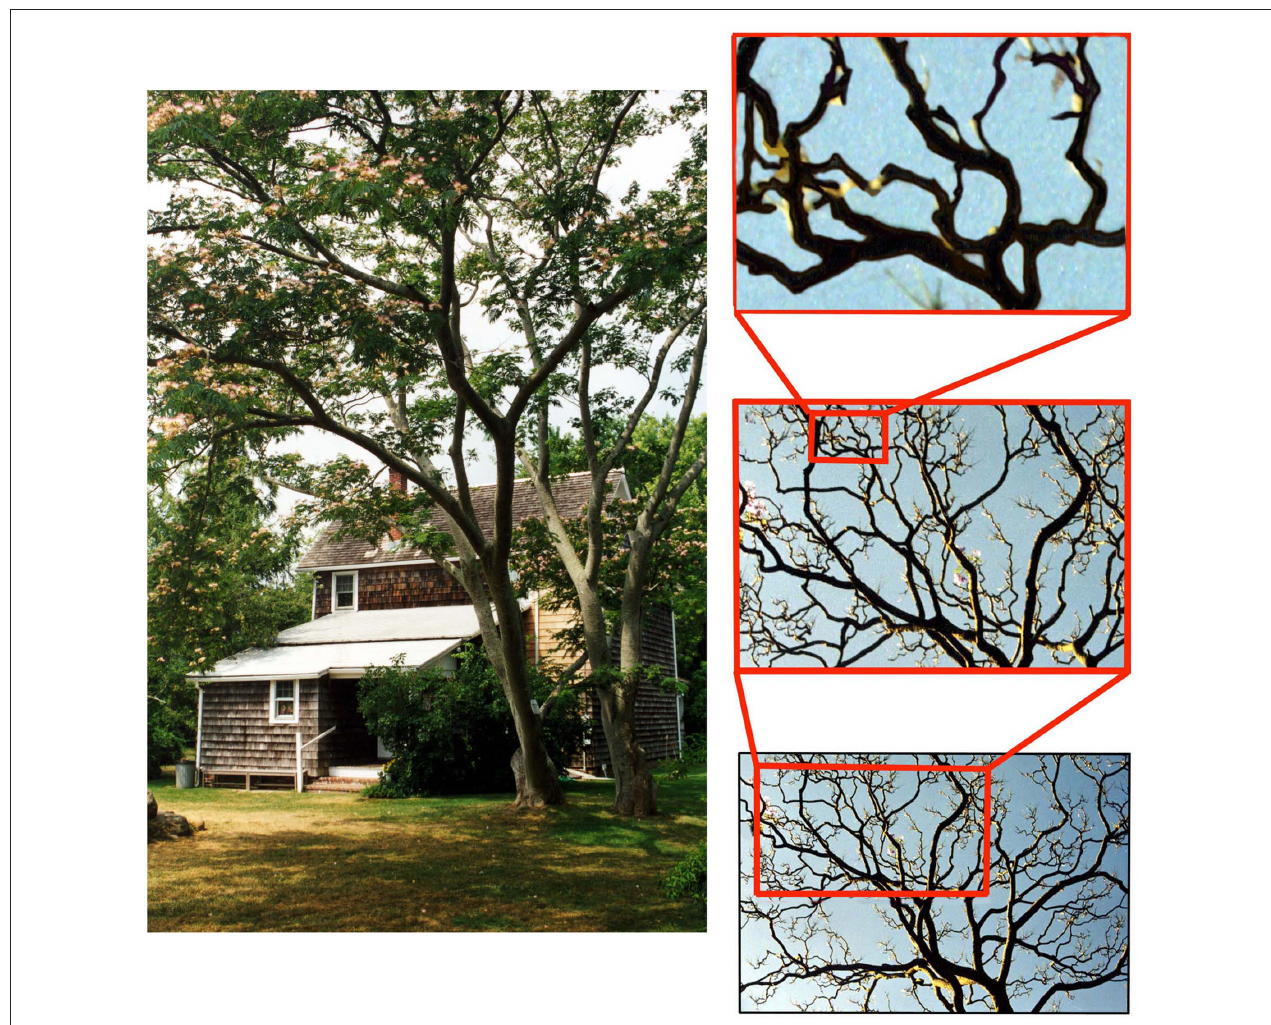
FiGurE 1 | Left: Pollock’s house on Long island. In contrast to his previous urban life in Manhattan, Pollock perfected his pouring technique surrounded by the complex patterns of nature. Right: Trees are an example of a natural fractal object. Although the patterns observed at different magnifications don’t repeat exactly, analysis shows them to have the same